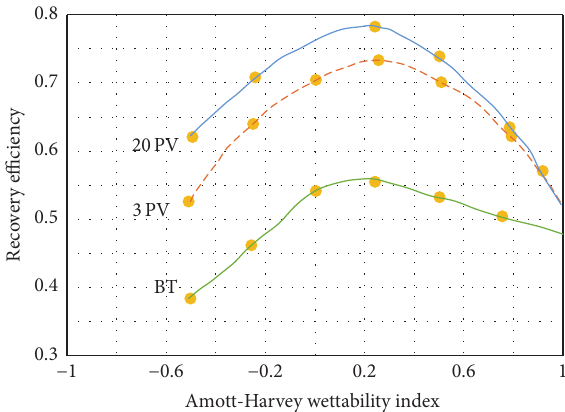
Figure 4: Recovery efficiency versus wettability index